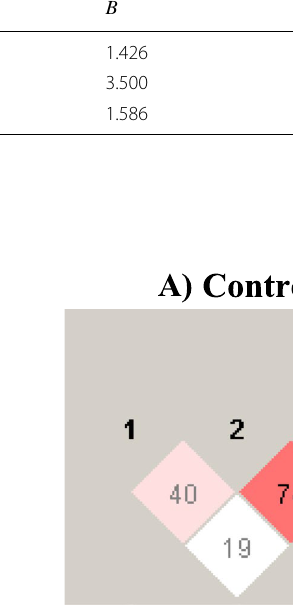
Fig. 1 Linkage disequilibrium between (1) rs11556218, (2) rs4778889, and (3) rs4072111 in A control and B OA